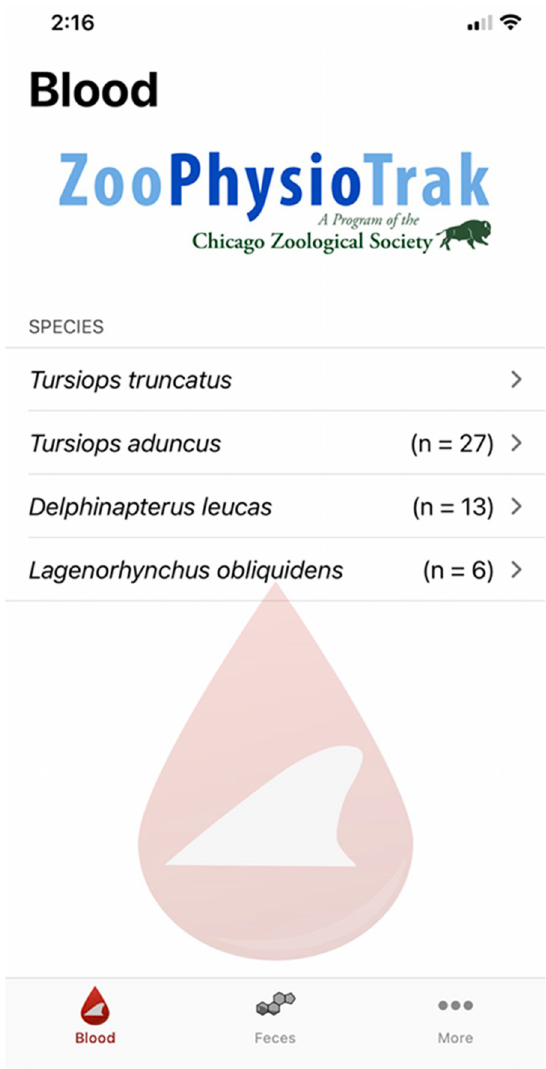
Fig 1. Screenshot taken on an iPhone device illustrating the user interface for the species selection